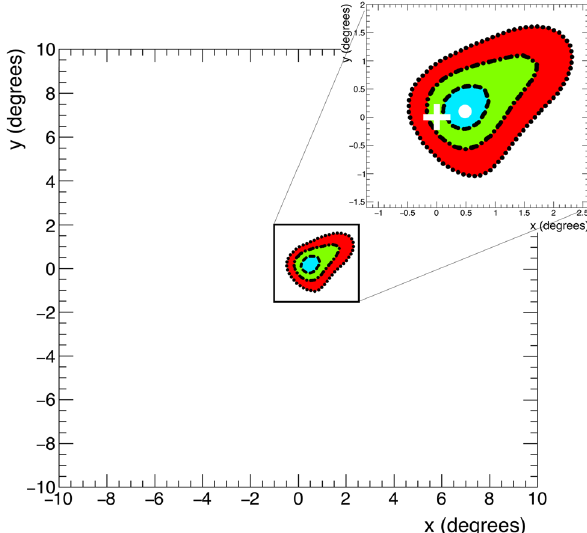
Fig. 6 Contour plots corresponding to different confidence lev- els (cyan/dashed: 68.27%; green/dot-dashed: 95.45%; red/dotted: 99.73%), computed with the two methods described in the text. In the zoom, the dot represents the position in the FoV where λ min = − 17 .